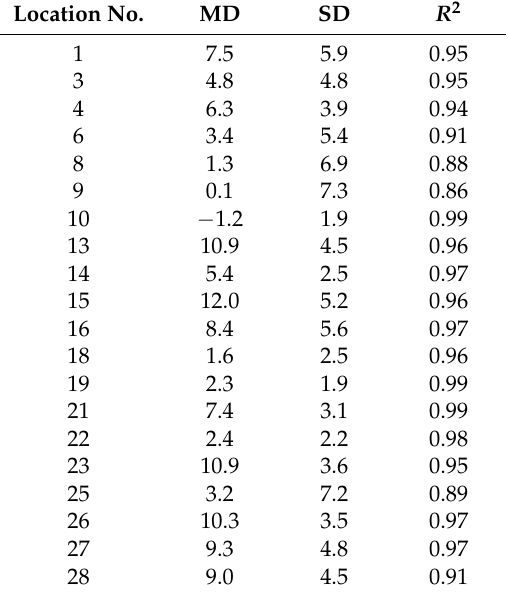
Table 2. Mean difference (MD), standard deviation (SD), and linear regression correlation ( R 2 ) between hourly T surface and T air at measurement locations over all days. Measurement locations 2, 5, 7, 11, 12, 17, 20, and 24 were unable to be used due to sensor malfunctions and missing data values. Location No.